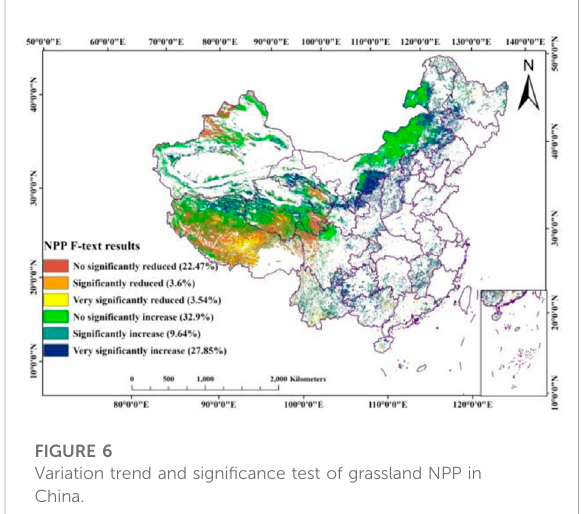
FIGURE 6 Variation trend and signi fi cance test of grassland NPP in